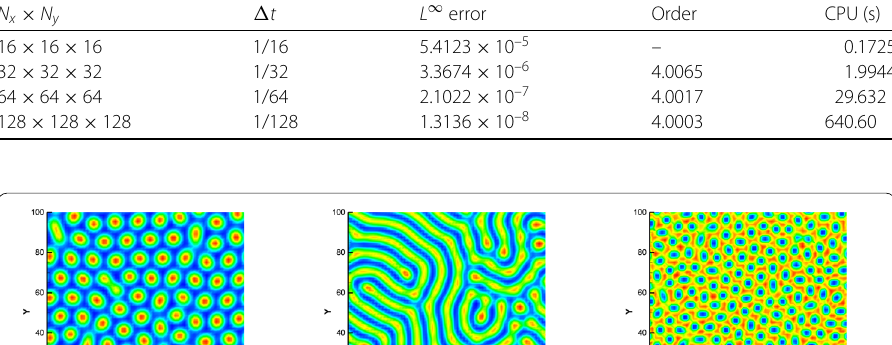
Table 4 Error, order of accuracy, and CPU time with DC4 scheme for Example 2 N x × N y